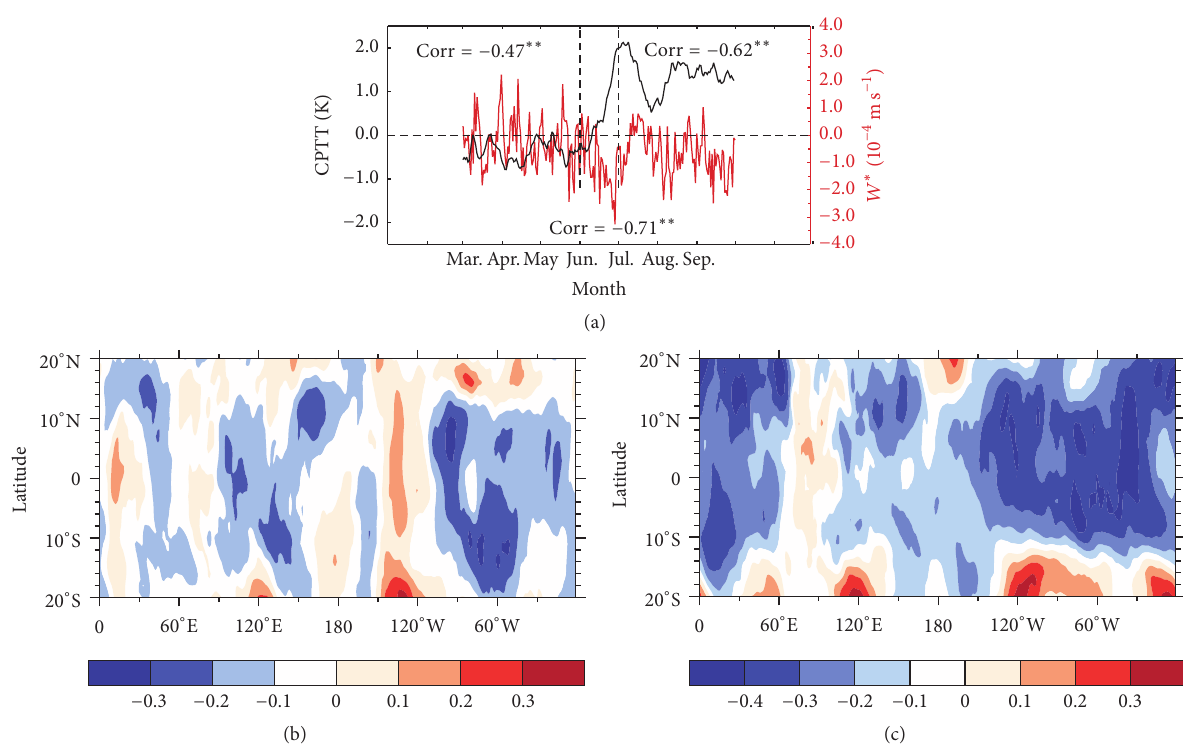
Figure 7: (a) Same as Figure 3(b) but for CPTT and 100hPa vertical velocity of the BDC. The maps of correlation coefficients between CPTT and 100hPa vertical velocity of the BDC over the tropical region during the “prewarming” (b) and “postwarming” (c) periods. “ ∗∗ ” denotes that the correlation coefficients exceed the significance test at the 95% confidence